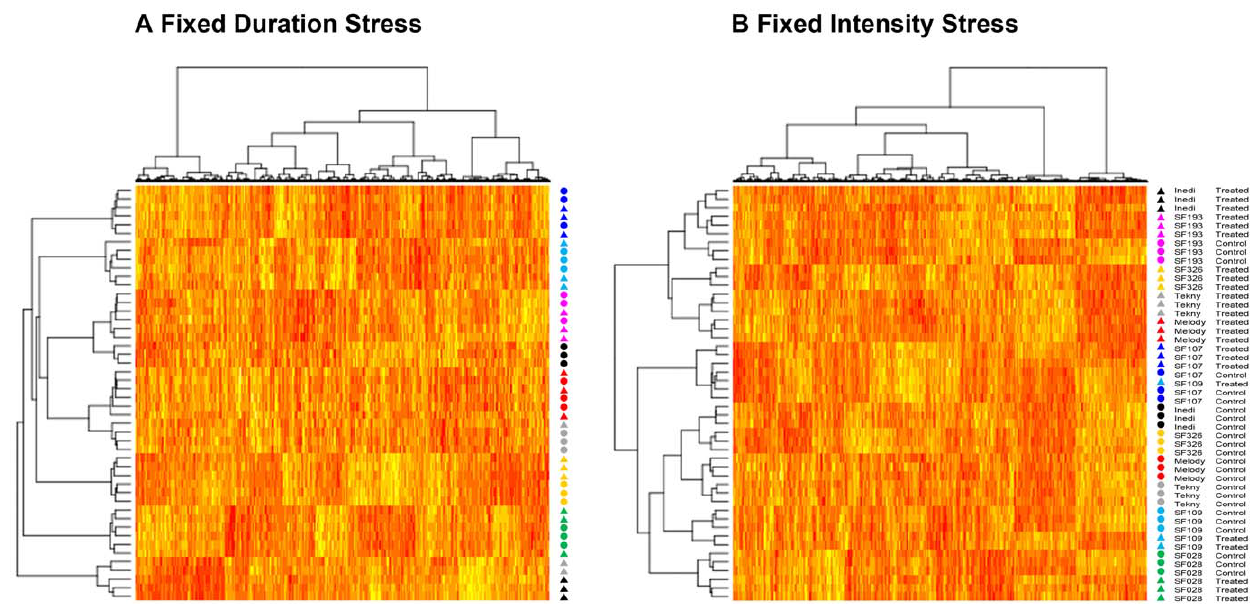
Figure 2. Dendograms and heatmaps of genes and individuals both under FDS (A) and FIS (B). Triangles correspond to treated plants whereas circles correspond to their untreated counterparts. Genotypes are color-coded as follows: Inedi (black), Tekny (gray), Melody (red), SF109 (turquoise), SF326 (yellow), SF193 (magenta), SF028 (green) and SF107 (blue).